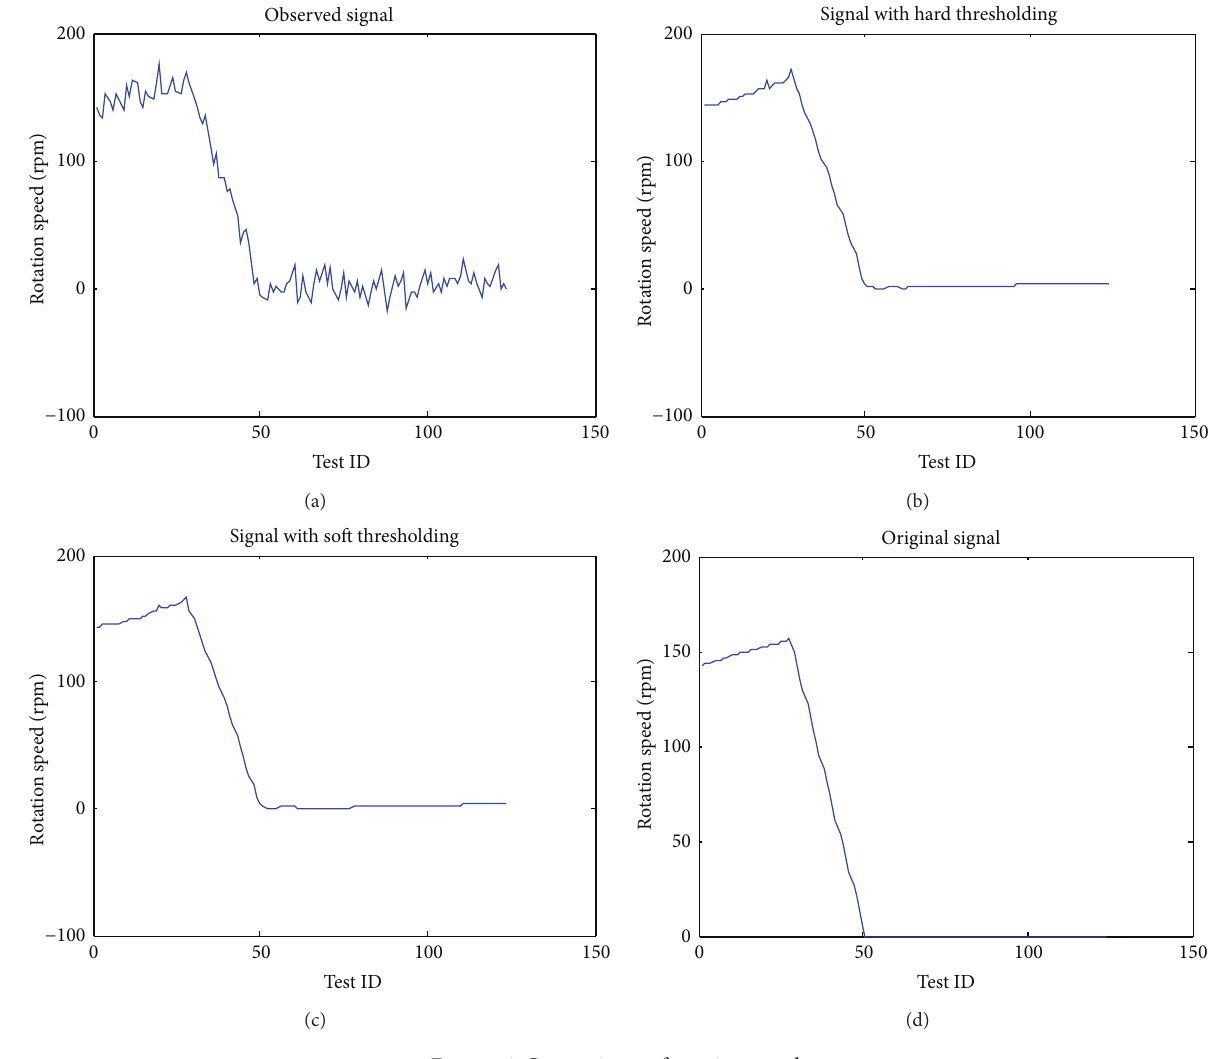
Figure 6: Comparisons of rotation speed.